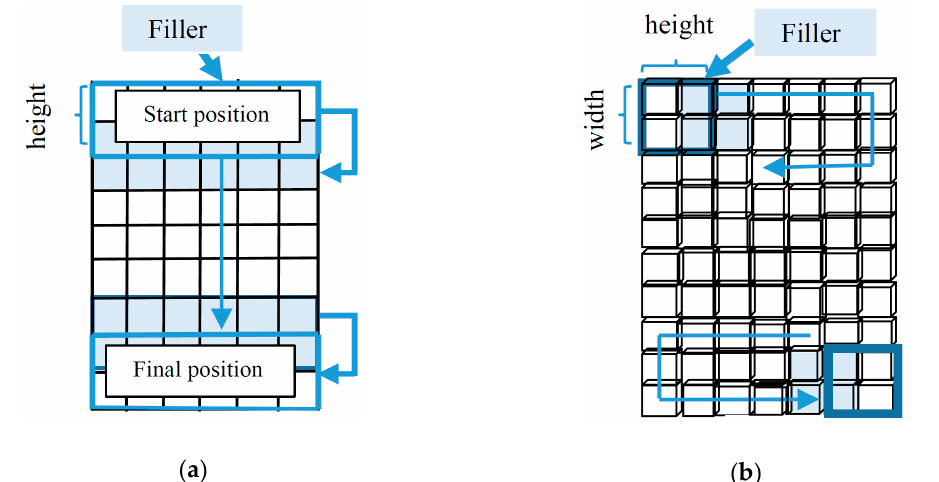
Figure 6. The sliding direction of the filter on 1D ‐ CNN and 2D ‐ CNN, respectively. ( a ) The sliding direction of the filter on 1D ‐ CNN. ( b ) The sliding direction of the filter on 2D ‐ CNN. O ne ‐ dimensional convolutional neural network (1D ‐ CNN) is often applied to time ‐ sequences,